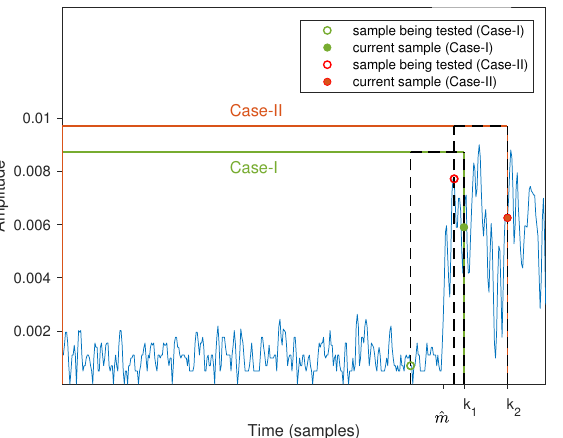
Figure 6. Growing reference window (solid lines) and sliding test window (dashed lines) for two different time instants k 1 (Case-I) and k 2 (Case-II).